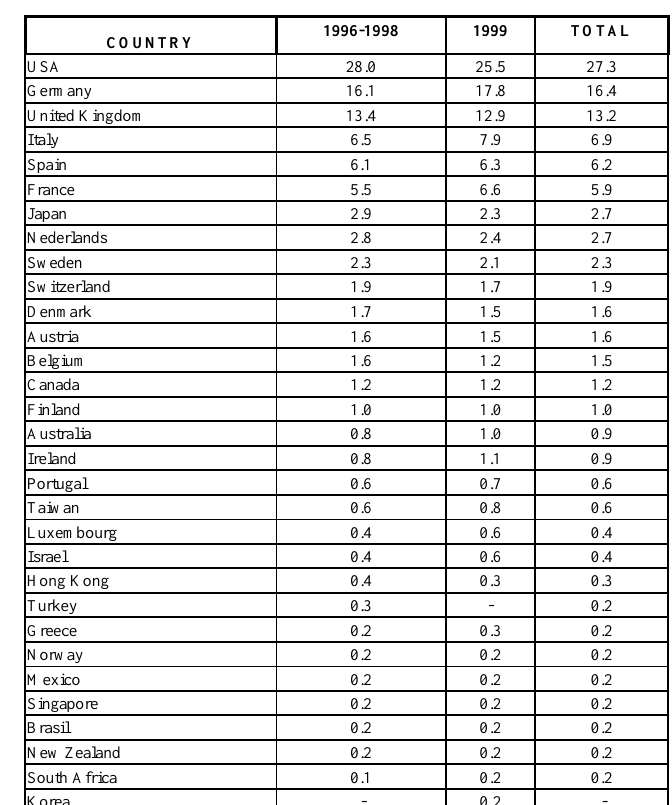
Table 1: Applications Based on Country of Origin (Overall Totals of First 30 Countries,